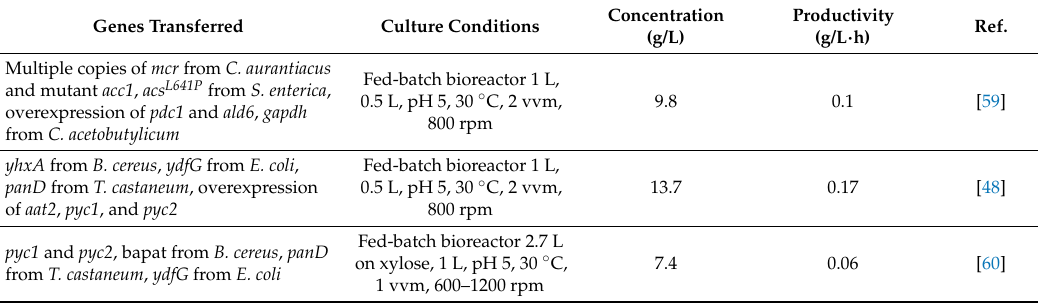
Table 5. Results of 3HP production from glucose using S. cerevisiae as host microorganism. Genes Transferred Culture Conditions